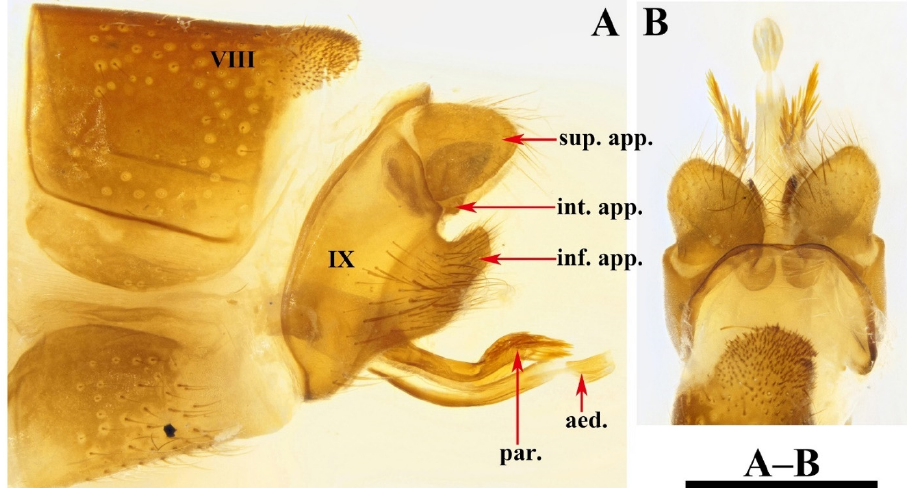
Figure 16. Limnephilus fuscovittatus , male genitalia. ( A ) Left lateral; ( B ) dorsal. Abbreviations: sup. app. = superior appendages (paired); int. app. = intermediate appendages (paired); inf. app. = inferior appendages (paired); aed. = aedeagus; par. = paramere. Scale bar: 1